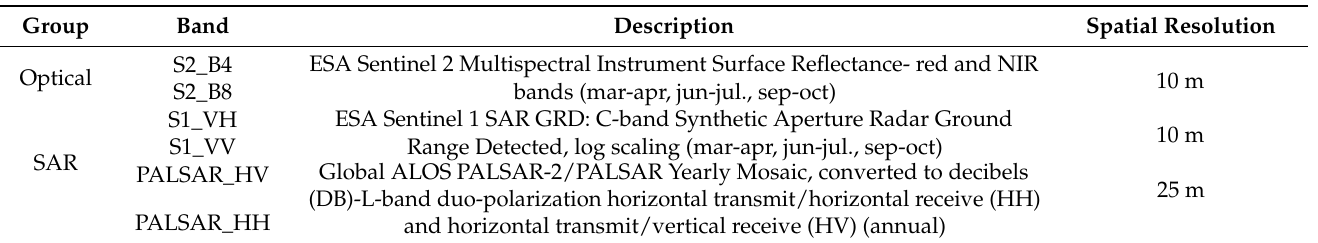
Table 1. Summary of covariates used in this study for canopy height modeling using the random forest algorithm. Description Spatial